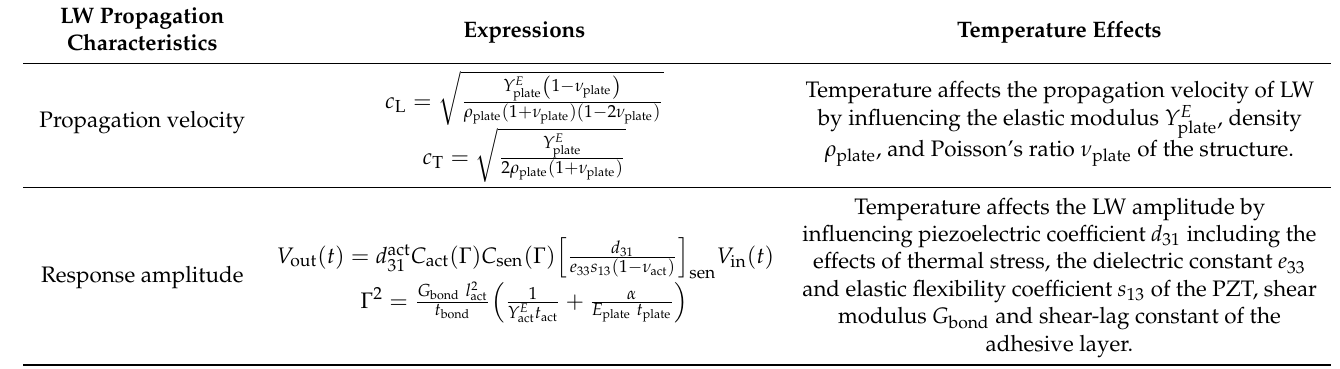
Table 1. Summary of Lamb Wave theory model and key parameters influenced by temperature. LW Propagation